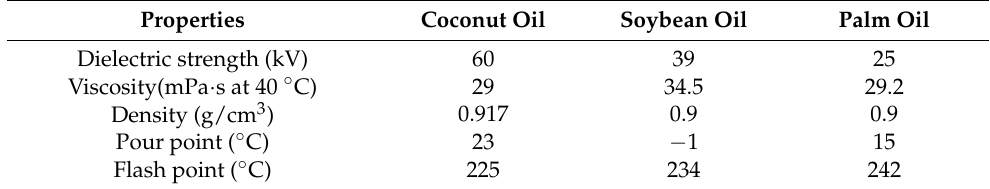
Table 2. Properties of vegetable